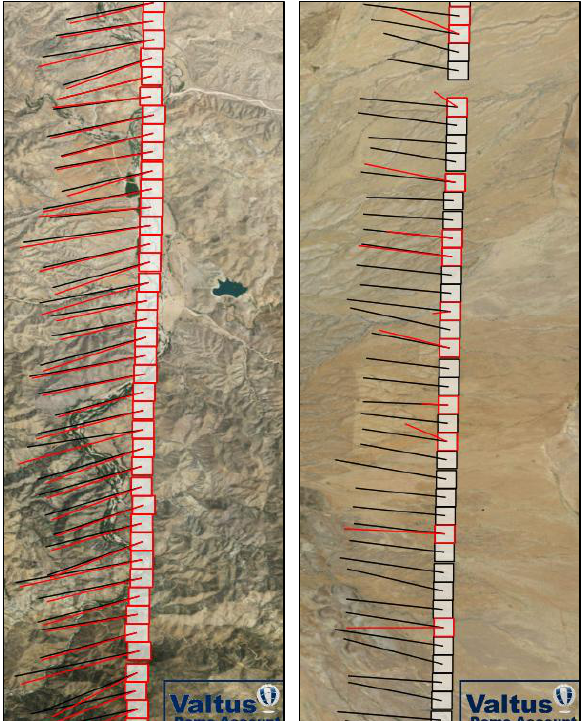
Figure 2. Patch locations and planimetric offset results for the geometric point cloud matching (red) and the combined method (black). Examples for the New Mexico strip overlap; offset vectors scaled by a factor of